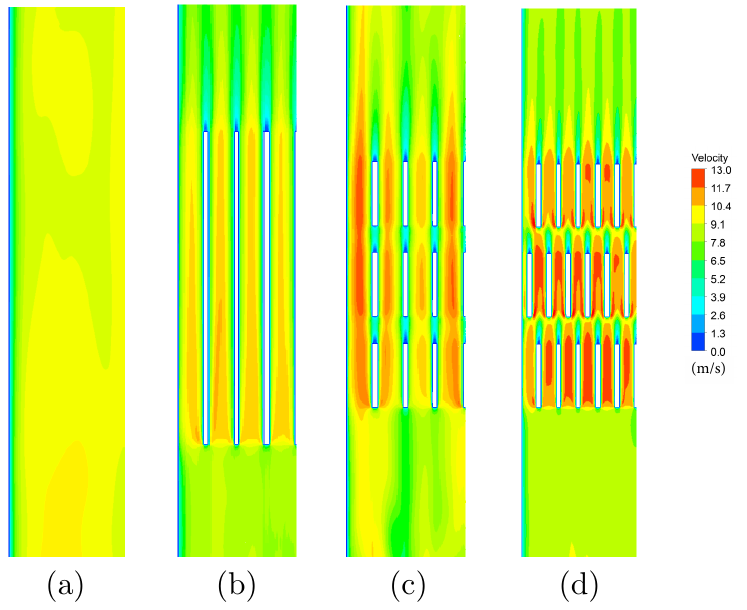
Figure 4. Velocity diagram at a vertical cut section inside the duct after the simulations with a gases temperature of 490°C and a mass flow of 100kg/h. ( a ) Flat inner surface; ( b ) Long fins; ( c ) Short aligned fins; and ( d ) Short misaligned